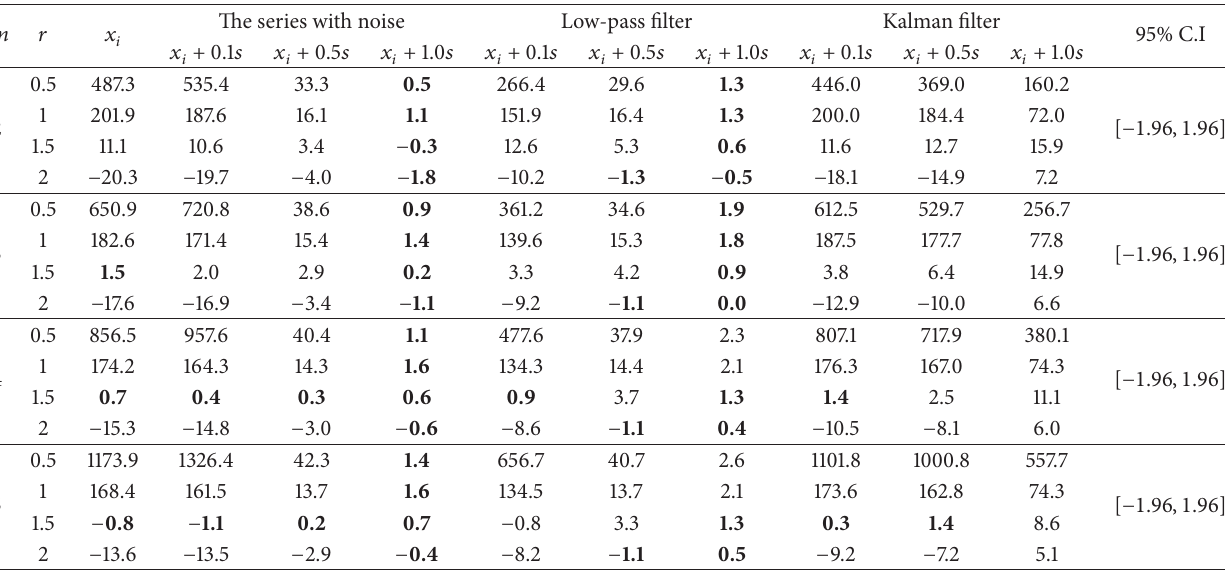
Table 2: The BDS statistic values for data series in each